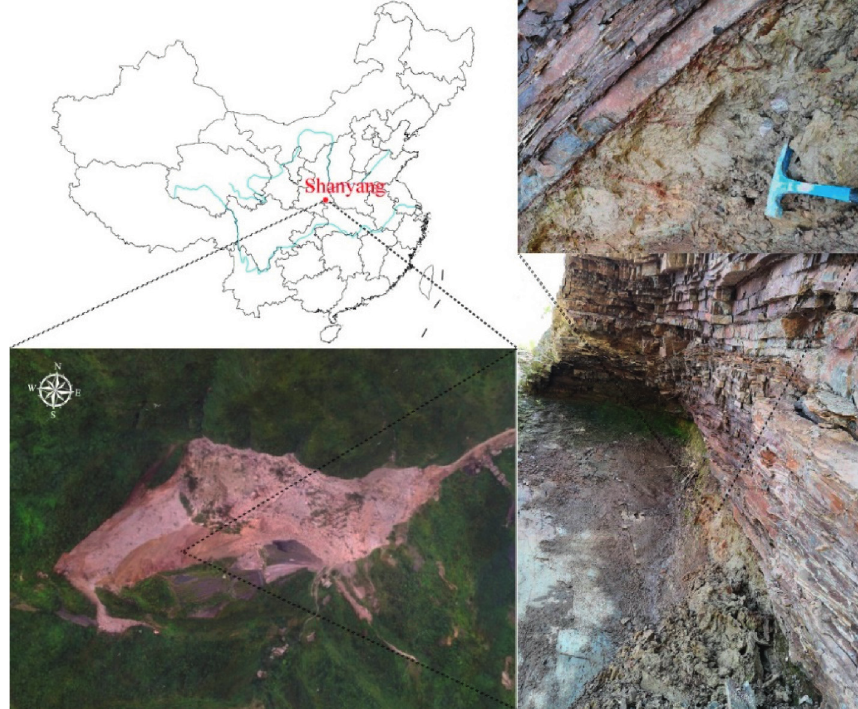
Figure 1: Sampling location map.